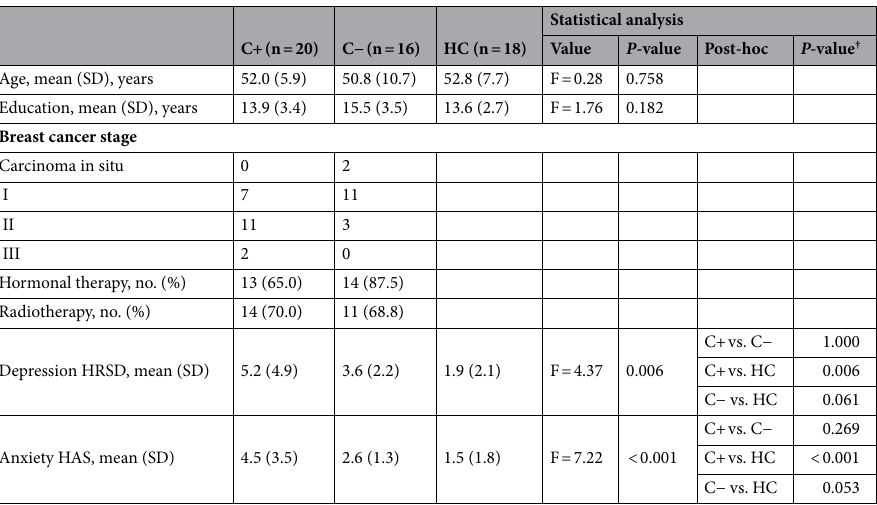
Table 1. Demographic and clinical characteristics of patients and controls. † Corrected P -values are derived from post-hoc comparisons with Bonferroni correction. C + patients treated with chemotherapy, C− , patients not treated with chemotherapy, HC healthy controls, HAS Hamilton anxiety scale, HRSD Hamilton rating scale for depression.